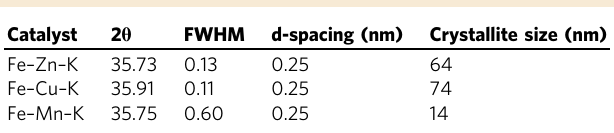
Table 2 Crystallite sizes of prepared catalysts (with different transition metal promoters) with the citric acid method.